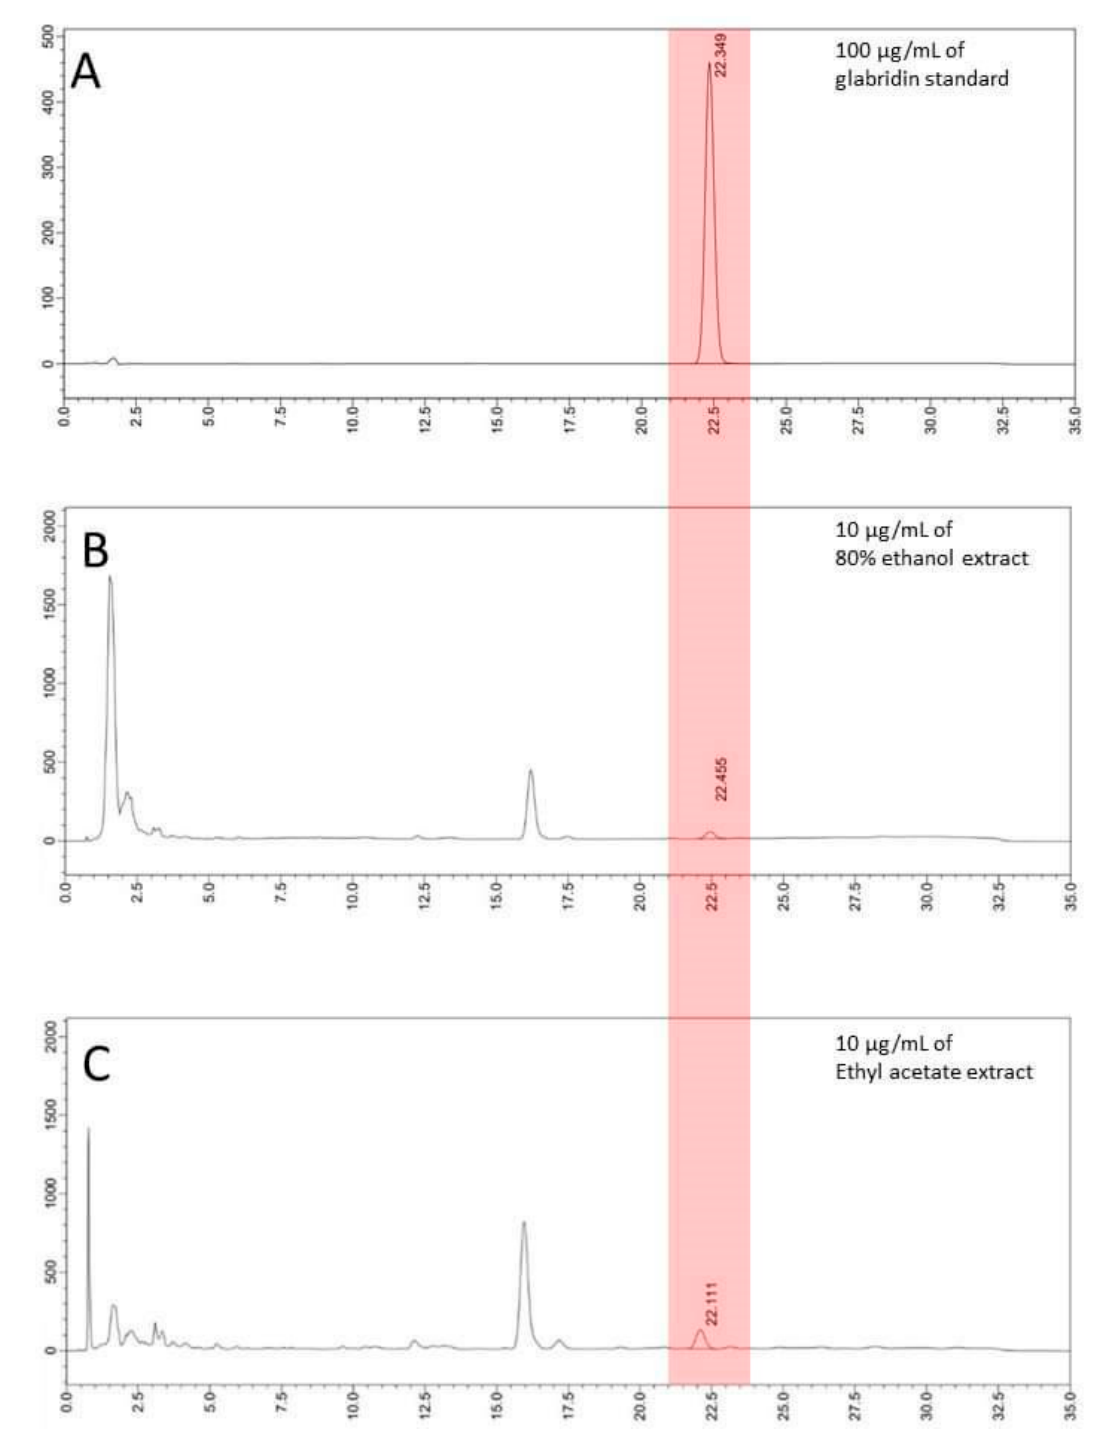
Figure 3. Determination of glabridin in HPLC chromatogram. ( A ) HPLC chromatogram of a standard reference at 100 µg/mL concentration. ( B ) HPLC chromatogram of 80% ethanol extract at 10 µg/mL concentration. ( C ) HPLC chromatogram of ethyl acetate extract at 10 µg/mL concentration. 230 nm is selected for glabridin detection. The red indicates peaks with a similar retention time to the glabridin standard peak.